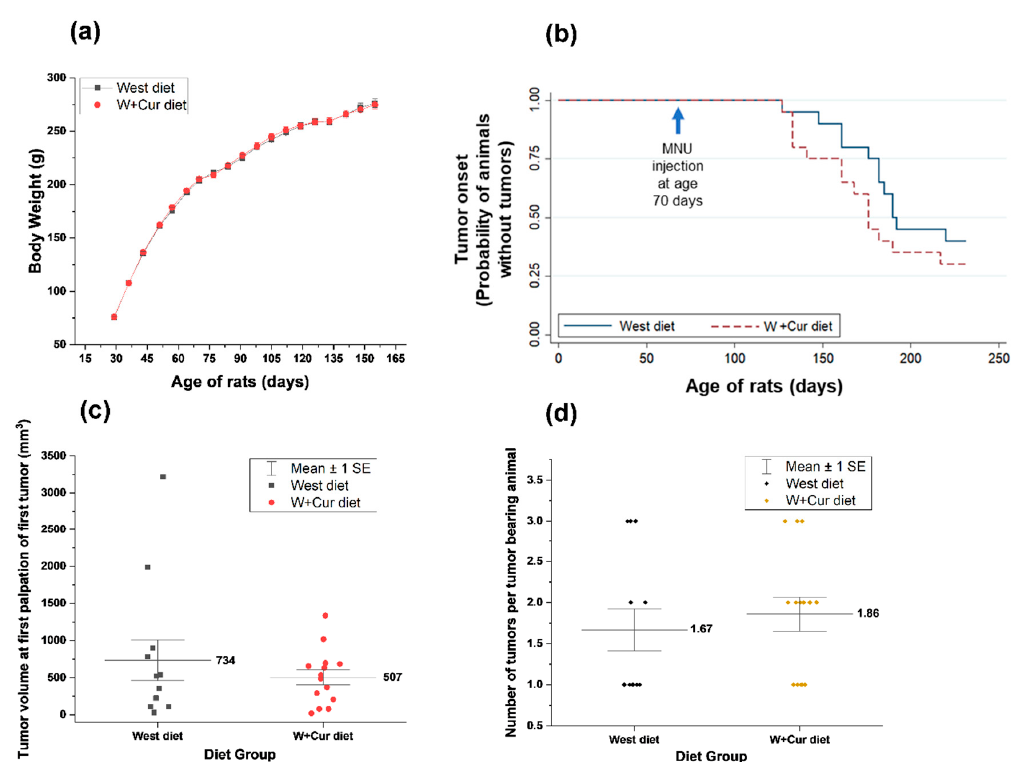
Figure 2. ( a ) The body weights of rats in both western (West) and western supplemented with 1% curcumin (W + Cur) diet groups. ( b ) Tumor onset analysis using Kaplan–Meier method. Y -axis shows palpable tumor) for both the groups. ( d ) Number of tumors per tumor bearing animal.